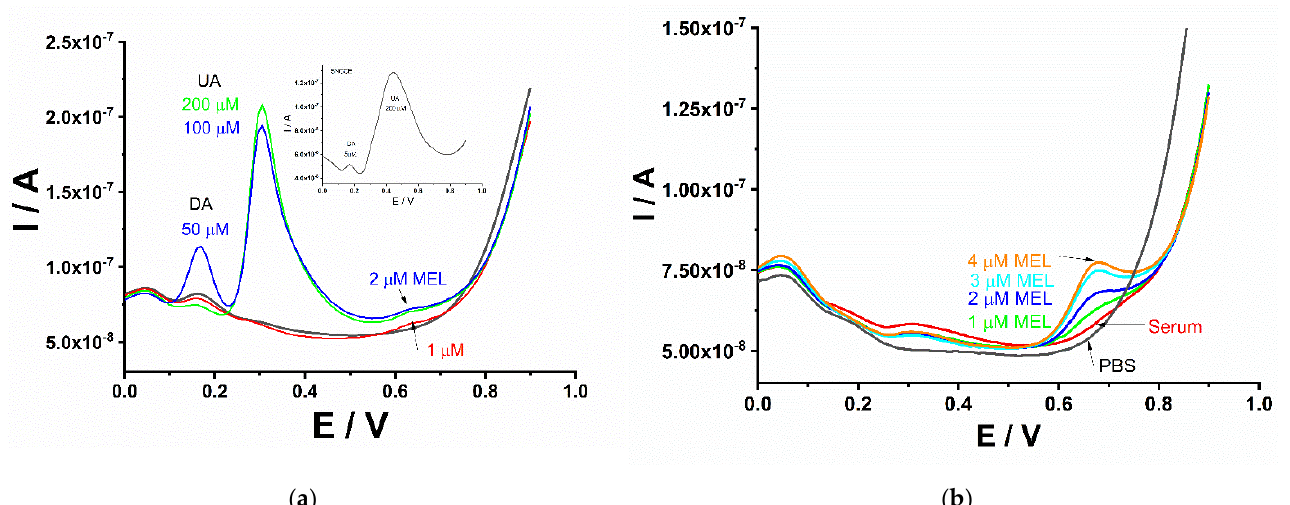
Figure 9. ( a ) DPVs recorded at SNGCE/AuNPs in 0.1 M PBS of pH 7 containing 100 and 200 µM UA, 50 DA, and different MEL concentrations of 1 and 2 µM. Inset: DPV recorded at SNGCE in 0.1 M PBS of pH 7 containing 200 µM UA, 5 µM DA, and 2 µM MEL. ( b ) DPVs recorded at